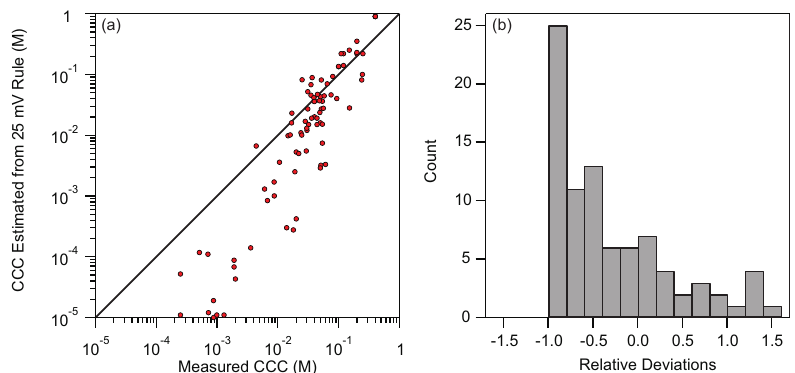
Figure 5. ( a ) Deviations of CCC estimated using the 25 mV rule and experimental CCCs. ( b ) Distribution of relative deviations between estimated CCCs using the 25 mV rule and measured